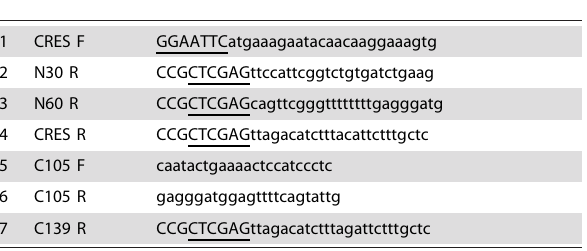
Table 1. The primer sequences used to amplify the CRES protein fragments and to construct the cysteine mutants of CRES.